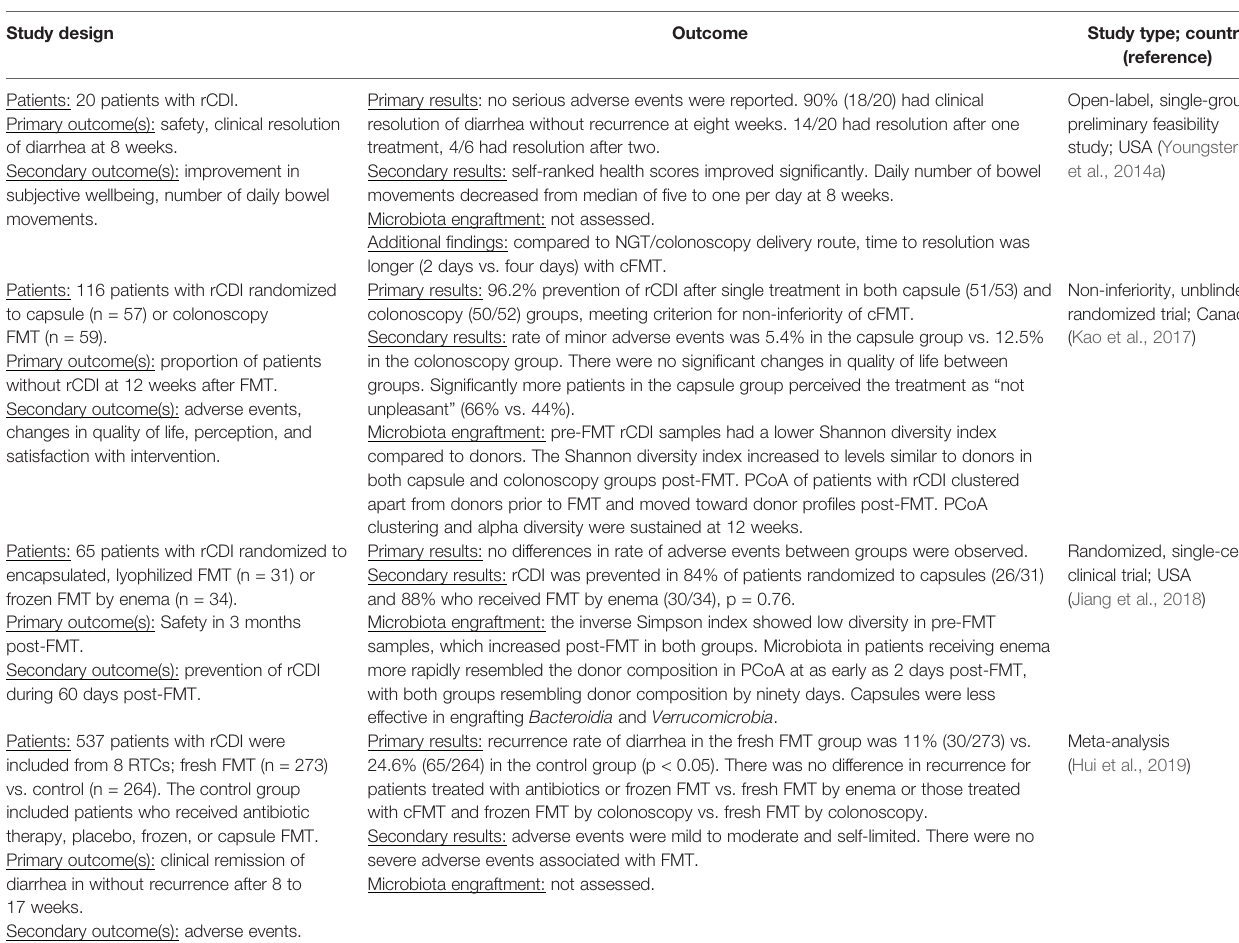
TABLE 1 | Summary of published cFMT clinical trials in rCDI. Study